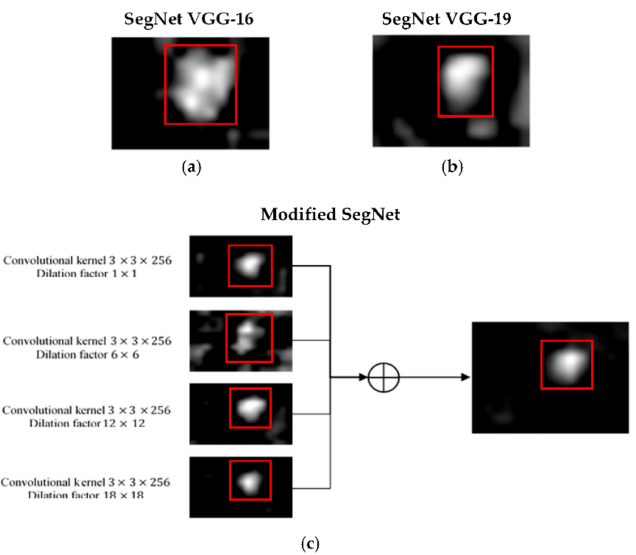
Figure A4. Intermediate sector between the encoder and decoder: ( a ) output activation map from the last max pooling layer in SegNet VGG-16; ( b ) output activation map from the last max pooling layer in SegNet VGG-19; ( c ) output activation maps from the ReLU layers from four different dilation factor convolution blocks (shown on the left), and the output of the ReLU layer from the convolution block after concatenation (shown on the right) for our modified SegNet network. The red boxes in the output activation maps indicate the location of